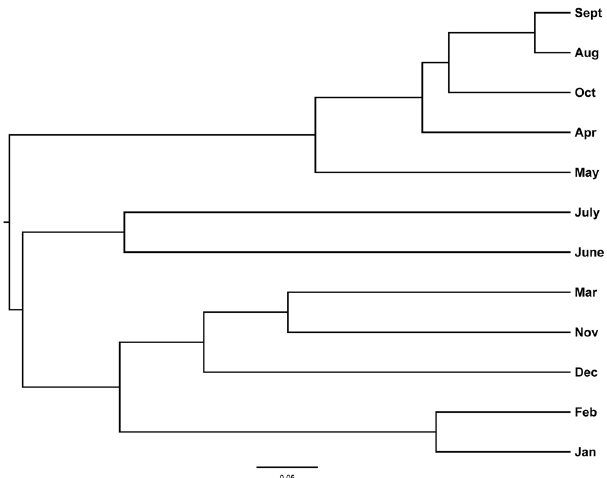
Figure 5. The tree showing the cluster of bacterial community using the Yue & Clayton theta similarity coefficient based on the sequences